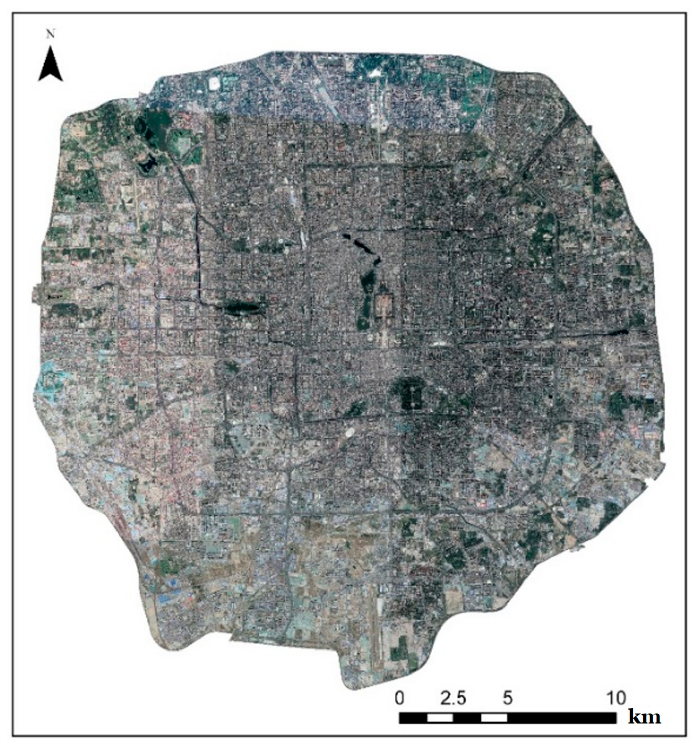
Figure A1. 1 m-resolution remote sensing imagery within the Fifth Ring Road of Beijing.